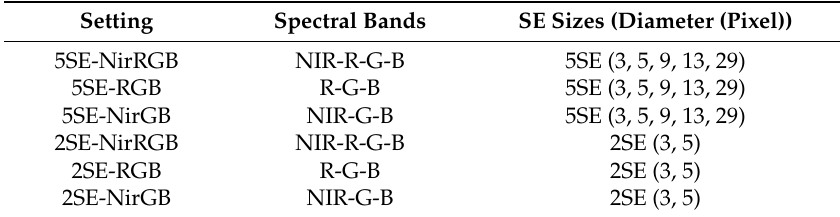
Table 3. Composition of spectral and textural